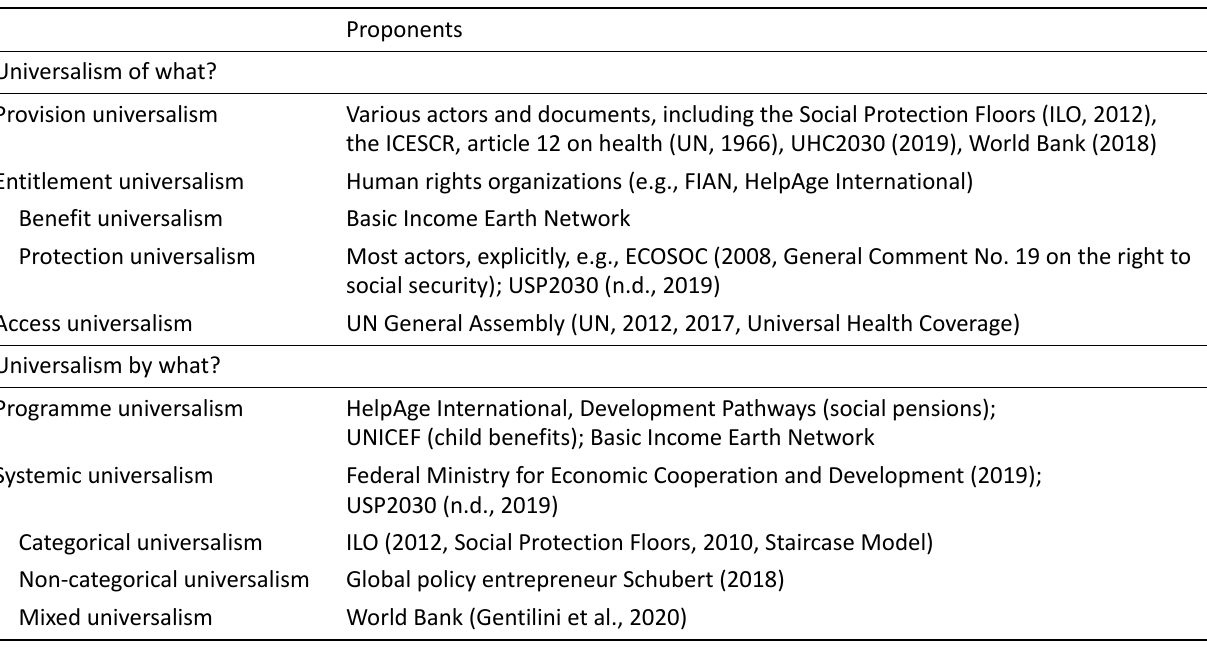
Table 1. Varieties of models of universal social